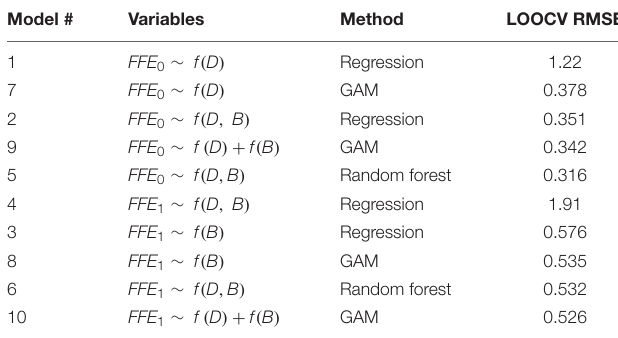
TABLE 8 | LOOCV RMSE results for statistical